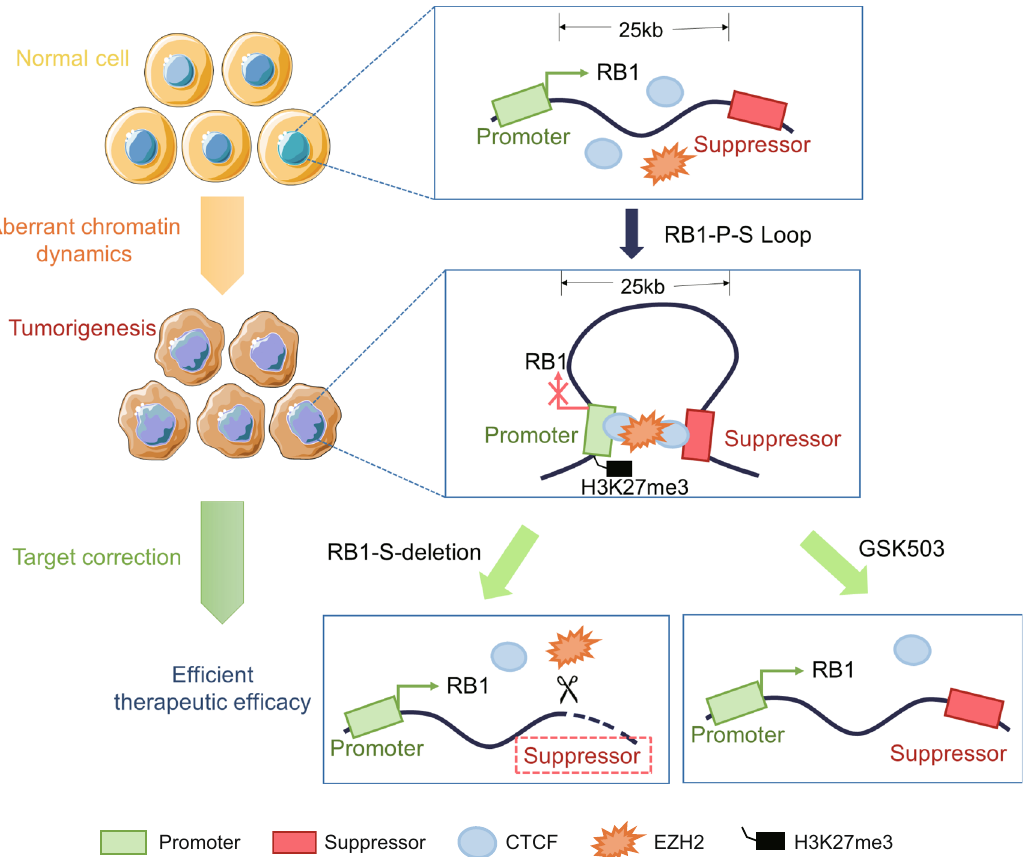
Fig. 7 Schematic diagram of the research model. When the CTCF-mediated chromosomal loop between the RB1 promoter and its 25 kb downstream suppressor was formed, EZH2 was then recruited and increased the level of H3K27me3 at the RB1 promoter, thereby inhibiting pRB expression and leading to tumorigenesis. The targeted correction of abnormal chromosomal interactions inhibited tumorigenesis by suppressor deletion or GSK503 inhibition. Every element of this image is new-created by the